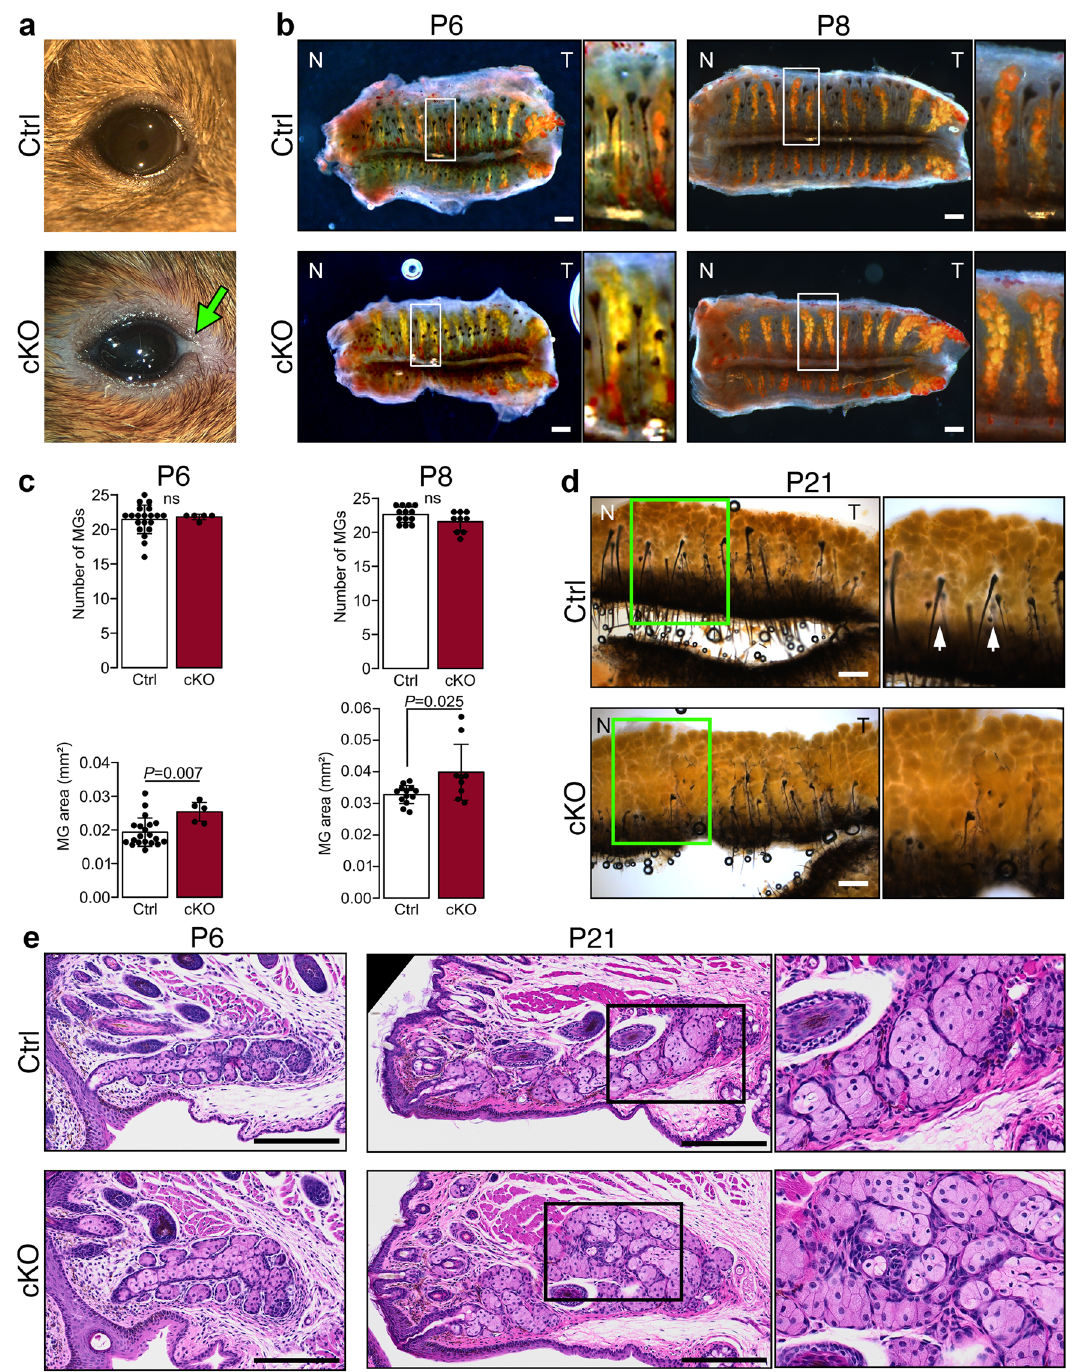
Fig. 1 Primary cilium ablation leads to larger MGs. a Representative pictures of control and cKO adult (6months) eyes. Arrow indicates a white deposit, only observed in cKO mice. b Representative images of tarsal plates stained withORO at P6 and P8. Boxed regions indicate the areas shown at higher magni fi cation. Scale bar, 200 µ m; N, nasal; T, temporal. c The number of MGs and MG size were quanti fi ed at P6 and P8 ( n = 20 controls and 5 cKO mice at P6; n = 13 controls and 9 cKO mice at P8). Per mouse, MG area was determined by averaging the MG area of all individual MGs in the upper and lower eyelids. Data were presented as mean±SD. Statistical signi fi cance was assessed using the Mann-Whitney test. ns, nonsigni fi cant, P ≥ 0.05. d Representative images of tarsal plates stained with ORO at P21. Boxed regions indicate the areas shown at higher magni fi cation. Scale bar, 200 µ m; N, nasal; T, temporal. e Representative images of control and cKO MGs stained with HE at P6 and P21. Boxed regions indicate the areas shown at higher magni fi cation. Scale bar, 200 µ m. were pooled for the entire study. Despite differences in MG size, Given the signi fi cant expansion of the mutant MGs, we asked histological analysis revealed that the morphology of basal and whether the lipid production and composition were altered in the differentiating meibocytes was similar in both mutant and control, cilia mutant. Lipid pro fi les of the tarsal plate extracts were assessed and no sign of duct obstruction was observed in mutant mice by high-resolution mass spectrometry (MS) in combination with (Fig. 1e). isocratic and gradient reverse-phase ultra-high performance liquid